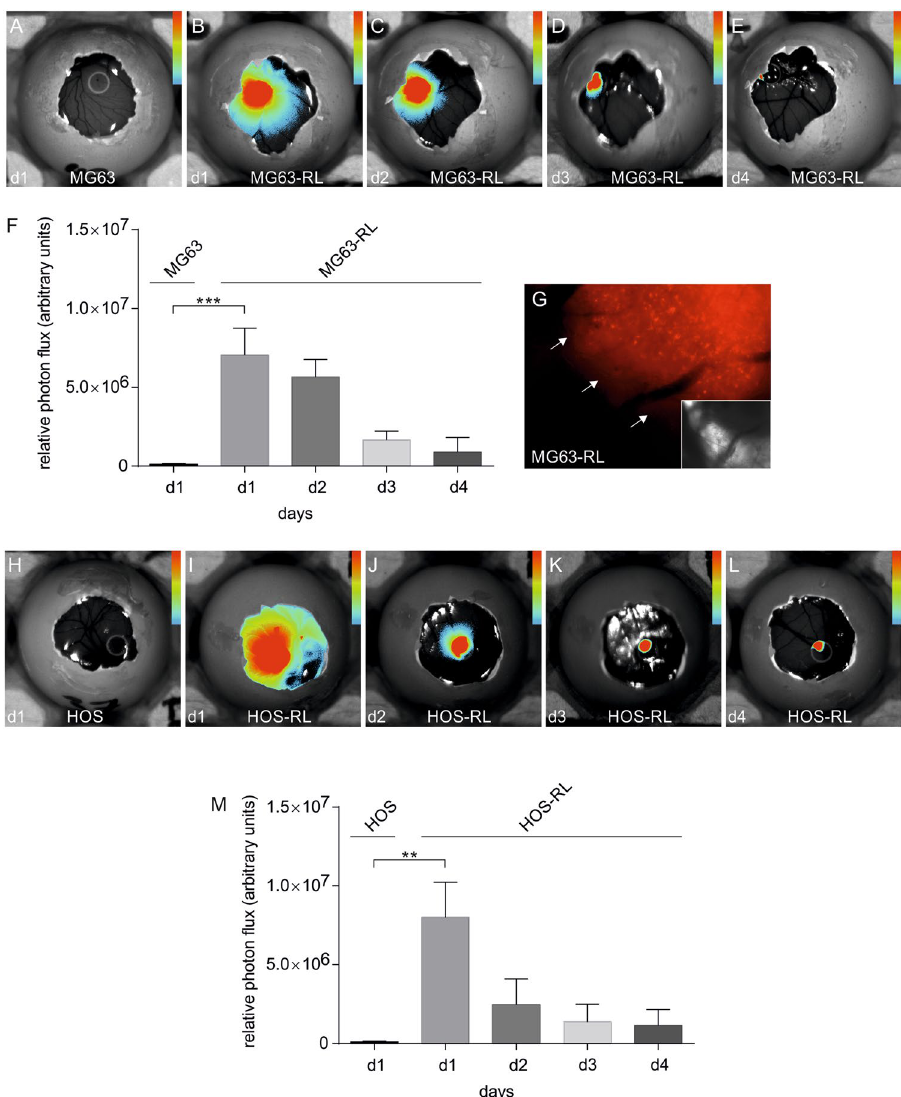
Figure 4. BLI of engineered osteosarcoma-BME scaffolds in the living chick embryo. ( A ) In vivo egg BLI of a MG63-BME control scaffold. ( B – E ) Representative images of daily in vivo egg BLI of MG63-RL-BME scaffolds over a course of 4 days. ( F ) In vivo egg BLI of a HOS-BME control scaffold. ( G – J ) Representative images of daily in vivo egg BLI of HOS-RL-BME scaffolds over a course of 4 days. ( K ) Quantitative BLI analysis are plotted as means with standard deviation (n = 4). Large insert: Post-mortem fluorescence microscopy on MG63-R-BME scaffold and adjacent CAM tissue. Small insert: Corresponding MG63-BME control scaffold. The inserts show the matching brightfield images. White arrows delineate the engineered tumors. ( L ) Corresponding quantitative BLI analysis are plotted as means with standard deviation (n = 3). All color bar inserts range from 0 (blue) to 16383 (red) units photon flux. ** p < 0.01, *** p <